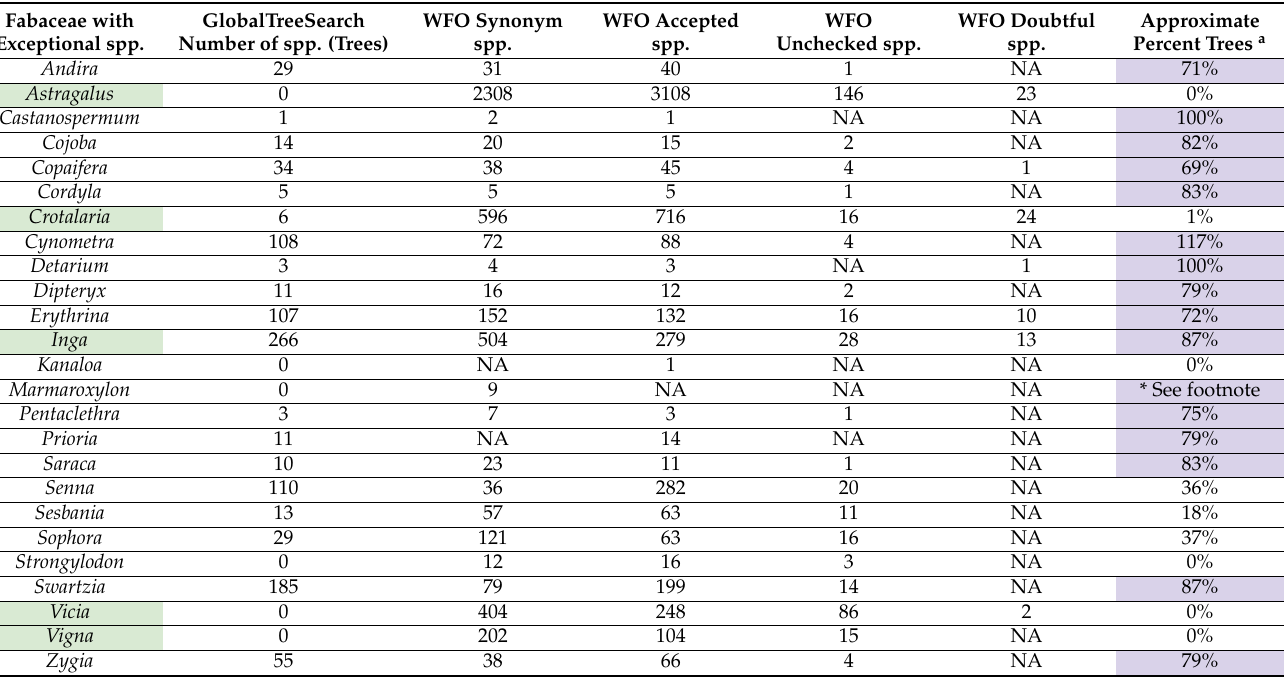
Table 4. Genera of Fabaceae with exceptional species evaluated for the percent of species of trees within each genus, as determined from GlobalTreeSearch [18].